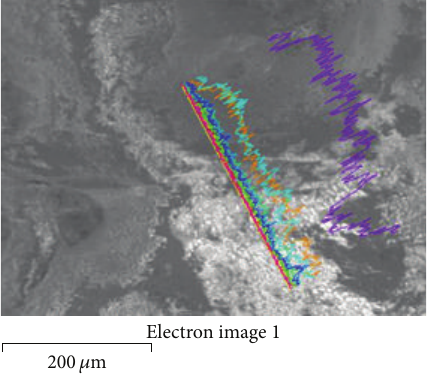
Figure 7: Appearance of cement paste sample without magnetic